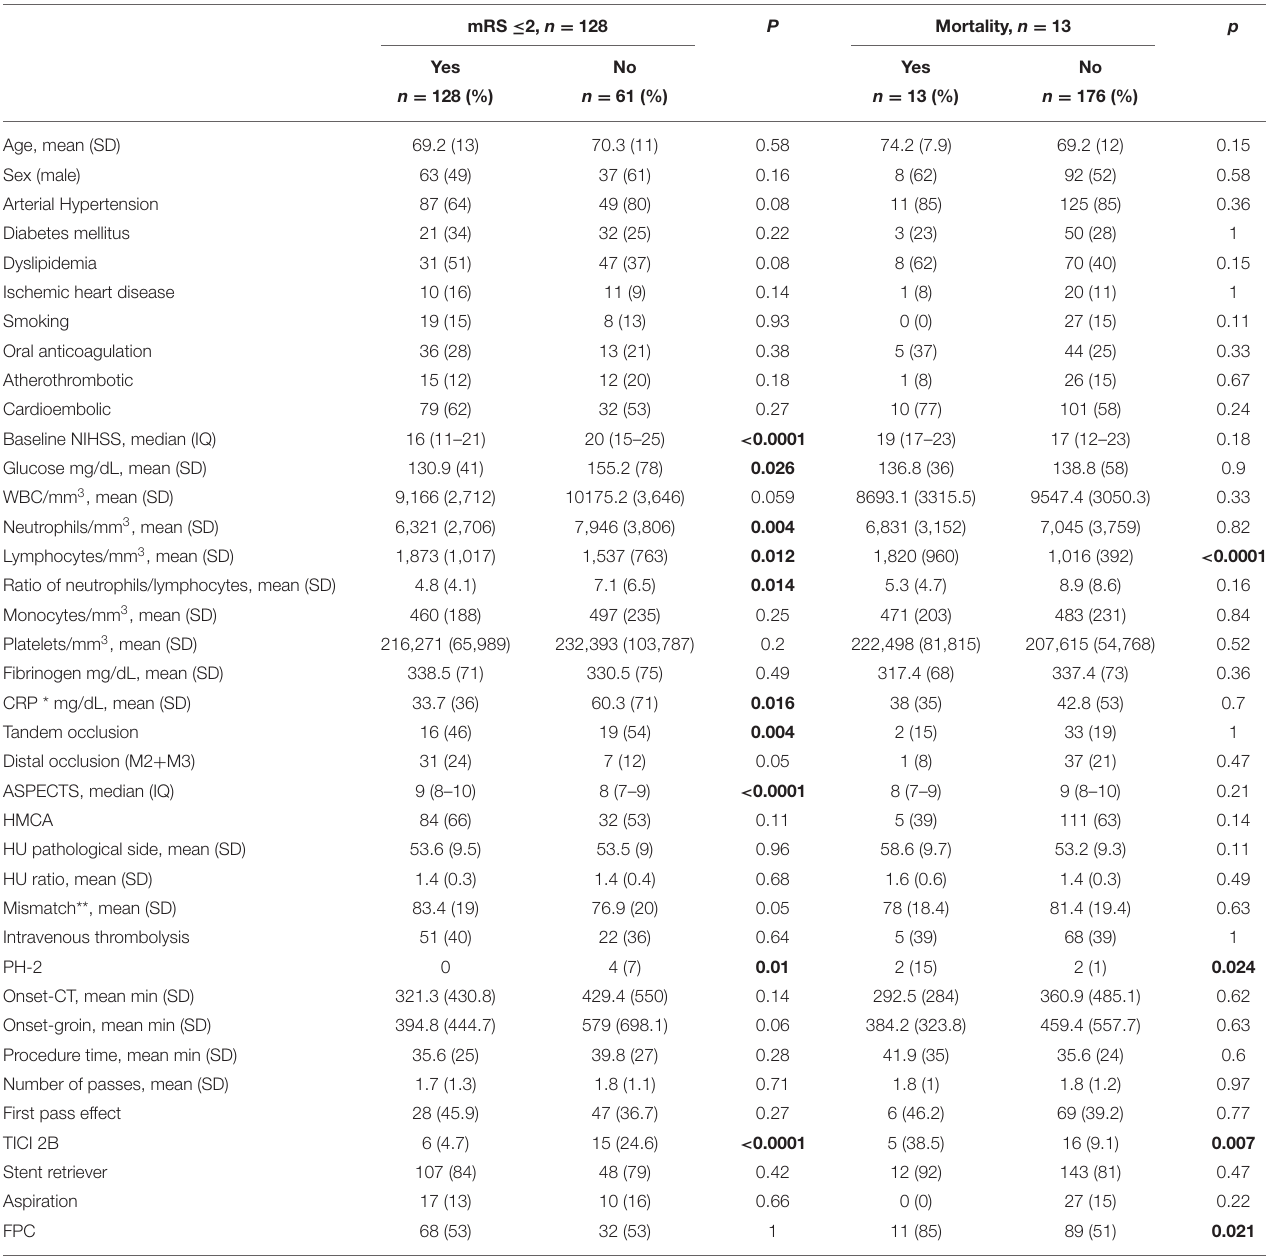
TABLE 5 | Bivariate analysis. Functional independence at 3 months and mortality. mRS ≤ 2, n = 128 P Mortality, n =